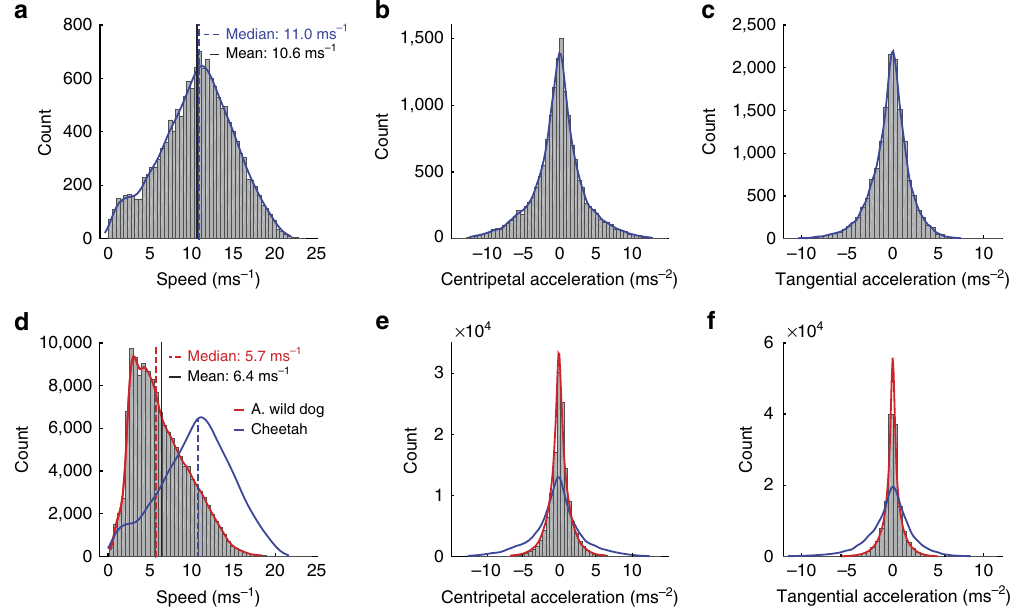
Figure 6 | Comparison of African wild dog and cheetah stride parameters. Histogram and kernel density estimate for cheetah ( a – c ; number of cheetahs N ¼ 5; number of strides n ¼ 15,845) and African wild dog ( d – f ; number of dogs N ¼ 6; number of strides n ¼ 140,141; including cheetah kernel density estimate normalized to African wild dog count (blue)). Horizontal stride speed ( a , d ); centripetal acceleration ( b , e ); tangential acceleration ( c , f ). African wild dog chases contain about twice as many strides as cheetah chases with a considerably greater number of straight strides at steady